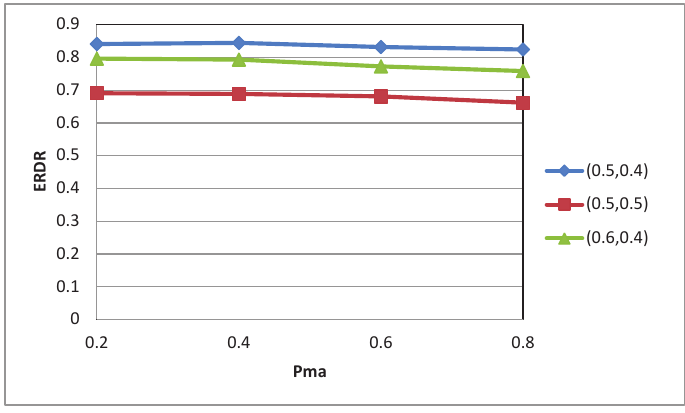
Figure 9. and boundary false alarm rate (BFAR) for various values of p